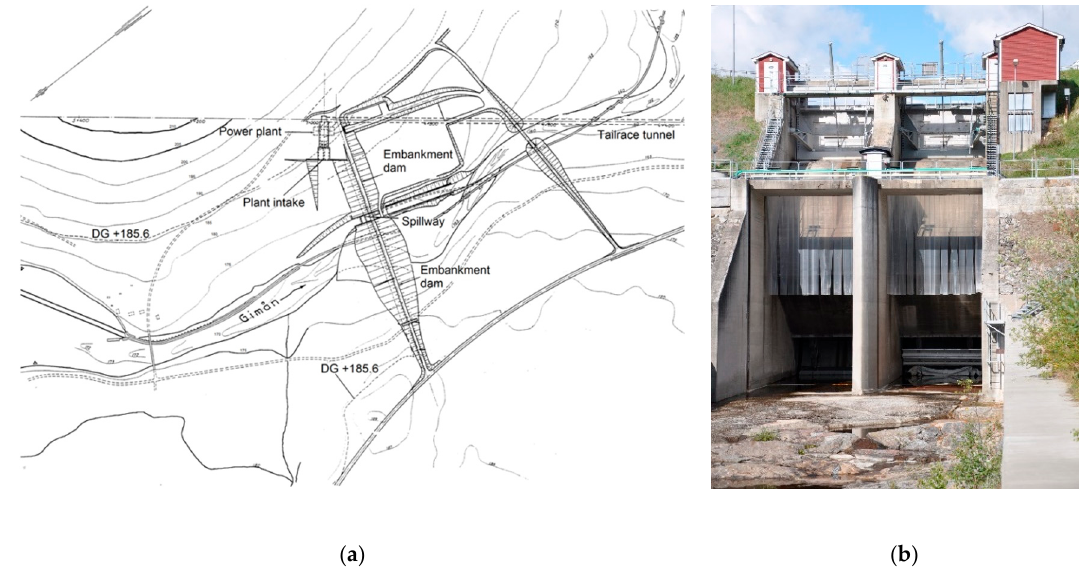
Figure 1. Hydropower scheme examined: ( a ) dam layout; ( b ) downstream view of spillway.